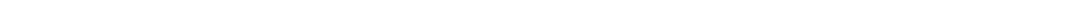
Fig. 7 Artemis functions epistatically with 53BP1 and RIF1 to promote alt-NHEJ. a 53BP1 or RIF1 depletion reduces the frequency of alt-NHEJ in both wild- type and BRCA2-depleted cells. 53BP1-, RIF1- or PTIP-depleted U2OS alt-NHEJ-EGFP cells were transfected with indicated siRNAs and then electroporated with pCBASce plasmid. After 48 h, the percentage of GFP-positive cells was determined by FACS. Results represent mean ± SEM of three independent experiments. b Knockdown ef fi ciency was con fi rmed by Western blotting. The Asterisk indicates a nonspeci fi c band. c Artemis functions epistatically with 53BP1 and RIF1 to promote alt-NHEJ. Wild-type or Artemis-de fi cient U2OS alt-NHEJ-EGFP cells infected with the indicated lentiviral shRNAs were transfected with control siRNA or siRNA against BRCA2. Twenty-four hours post transfection, cells were electroporated with pCBASce plasmid. After 48 h, the percentage of GFP-positive cells was determined by FACS. Results represent mean ± SEM of three independent experiments. d Loss of 53BP1 or RIF1 suppresses gross genomic instability in BRCA2-depleted cells. Wild-type, 53BP1-, PTIP-, or RIF1-de fi cient HeLa cells were transfected with indicated siRNAs, exposed to 10 Gy IR, and then allowed to recover for 2 or 24 h before being processed for immuno fl uorescence using antibodies against RPA2 and RAD51. Representative RPA2 and RAD51 foci and DAPI-stained nuclei are shown. e Quanti fi cation of RPA2/RAD51 foci and nuclear fragmentation. Data represent mean ± SEM of three independent experiments. Over 100 cells were counted in each experiment. f RIF1 is required for the retention of Artemis at laser-induced DSBs. 53BP1- or RIF1-depleted HeLa cells were transfected with indicated siRNAs. Forty-eight hours later, cells were transfected with GFP- Artemis and were then micro-irradiated and monitored by live cell imaging. Representative images taken at the indicated times after laser microirradiation are shown. g The fl uorescence intensity at the microirradiated site was quanti fi ed. Data represent mean ± SEM from at least 20 cells in three independent experiments. Scale bars, 10 μ